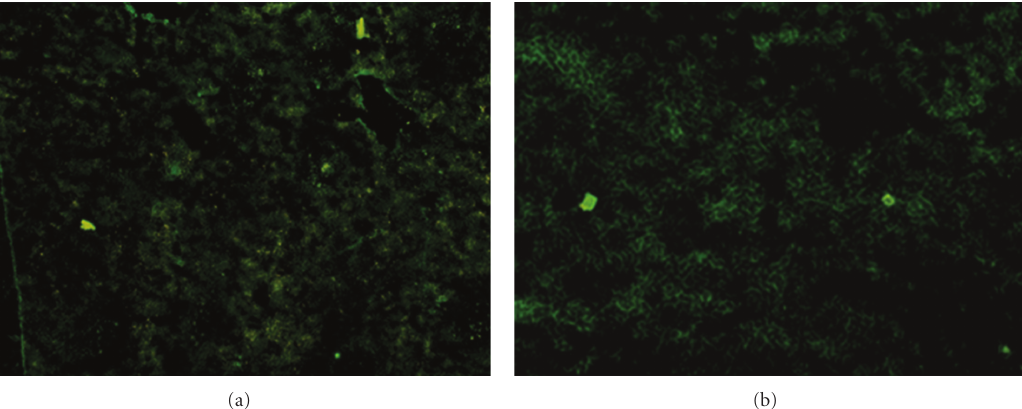
Figure 3: The expression of green fluorescence protein in the tissues of mice after TPG administration ( × 100). (a) spleen tissue; (b) tumor tissue.